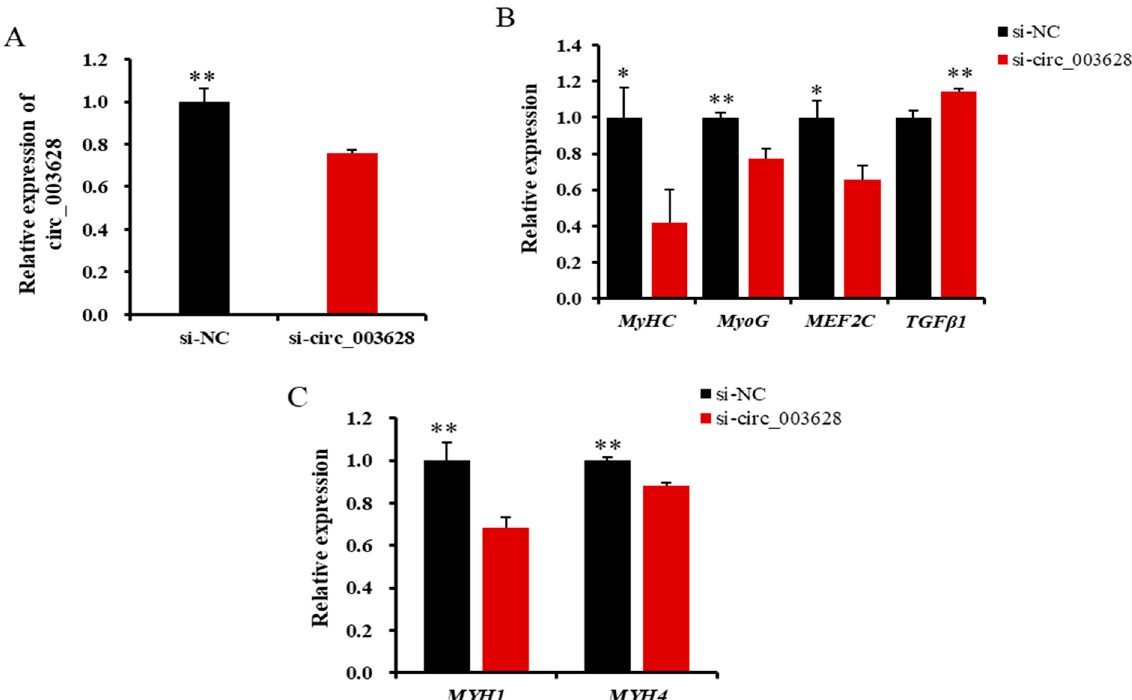
Figure 7. The relative expression level of circ_003628 ( A ), four cell differentiation marker genes ( B ) and its parent genes ( C ) when si-circ_003628 was transfected into SMSCs on day 6 after differentiation. * p < 0.05 and ** p < 0.01.